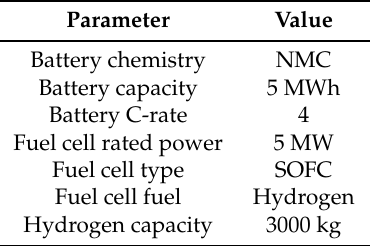
Table 2. Battery and fuel cell